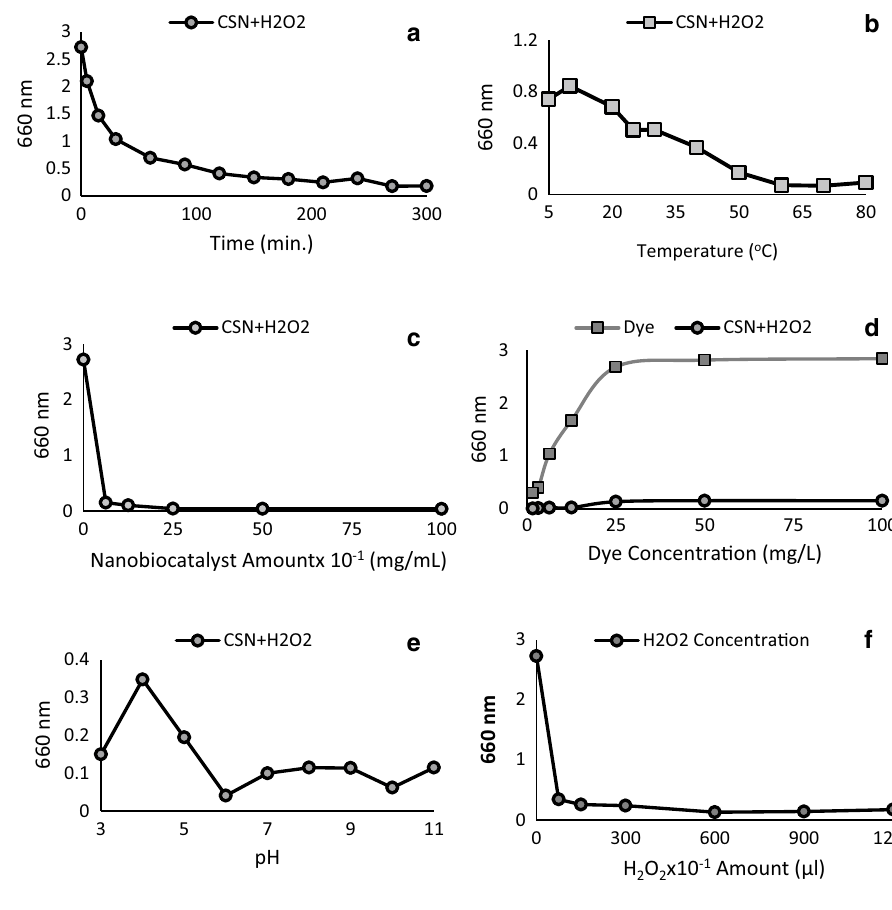
Fig. 2 a Effect of MB dye